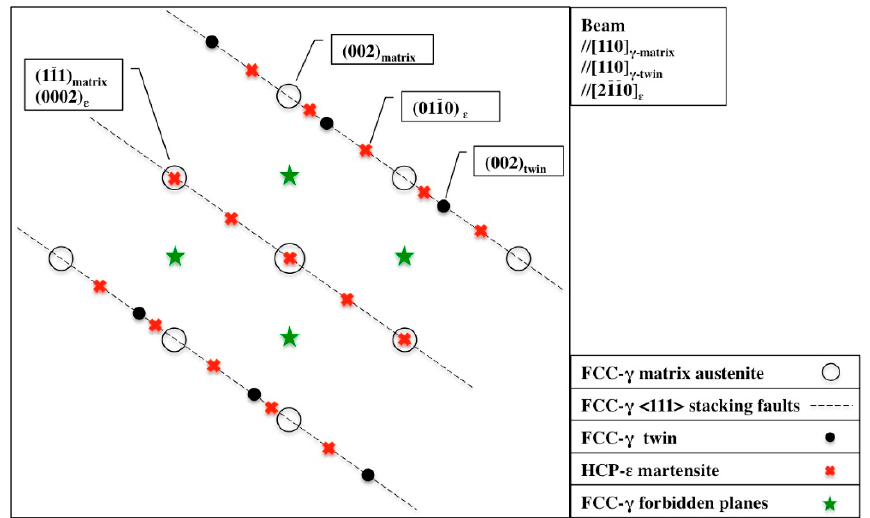
Figure 6. Sketch of the electron diffraction features observable in modified surface layers produced by low temperature nitriding. For further details, see [110]. (Reprinted from Acta Materialia, 164, X. Tao, X. Liu, A. Matthews, A. Leyland, The influence of stacking fault energy on plasticity mechanisms in triode-plasma nitrided austenitic stainless steels: Implications for the structure and stability of nitrogen-expanded austenite, 60–75, Copyright (2019), with permission from Elsevier).